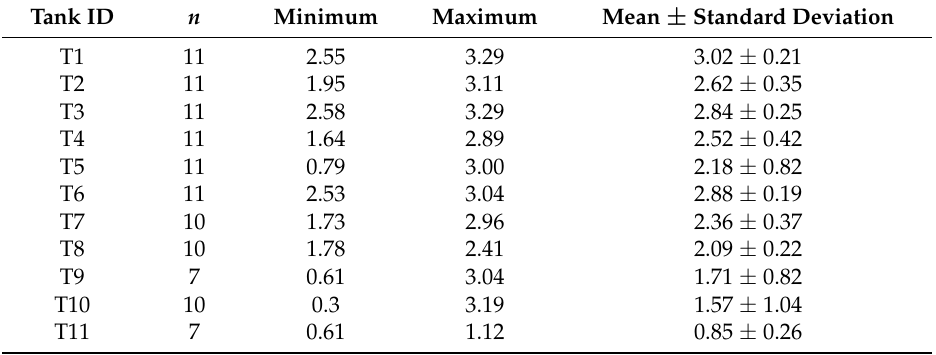
Table 2. Log transformed E. coli (MPN/100 mL) concentrations from various rainwater tanks.